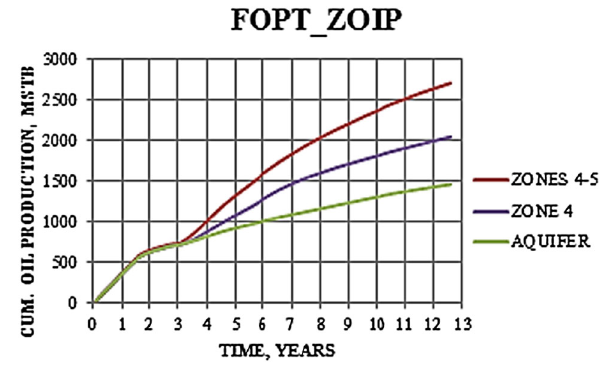
Fig. 13 Plot of field cumulative production versus time for the ZoIP scenarios for the five-spot